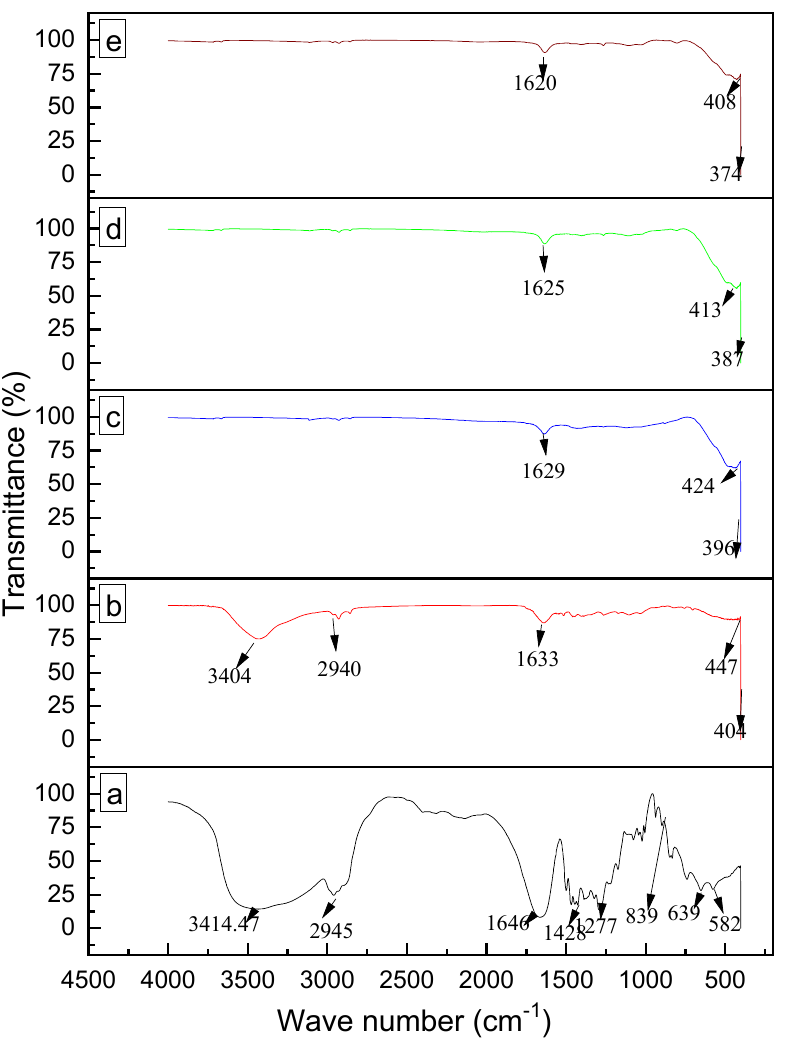
Figure 6. FTIR spectra of ( a ) PVP and bunsenite cadmium oxide at different temperatures: ( a ) room temperature, ( b ) 500, ( c ) 600, ( d ) 700, and ( e ) 800 °C.